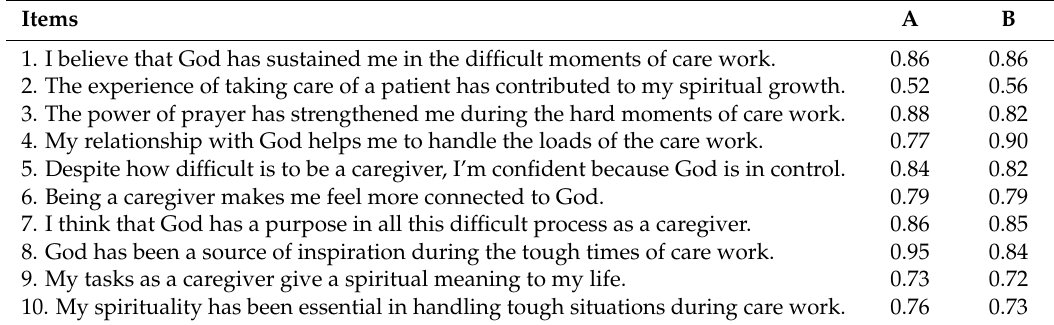
Table 2. Items of the Spanish version of CSS-10 and factorial loadings of the pilot study and the present